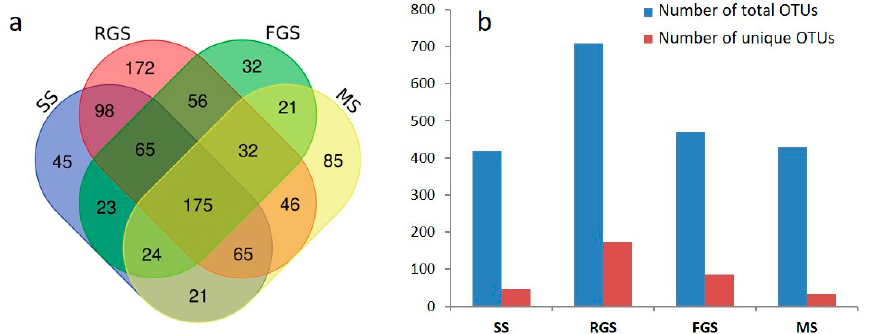
Figure 3. Comparison of fungal communities at different growth stages. ( a ) Venn diagram for samples among different combinations. Each ellipse represents a sample (group), with the number in the overlapping ellipses representing the number of operational taxonomic units (OTUs) shared between those samples (groups), and the number in the non-overlapping regions representing the number of unique OTUs of that sample (group). ( b ) Statistics of the OTUs number in different growth stages. Total OTUs refers to all the OTUs in a certain growth stage. Unique OTUs are those specific to a particular growth stage.